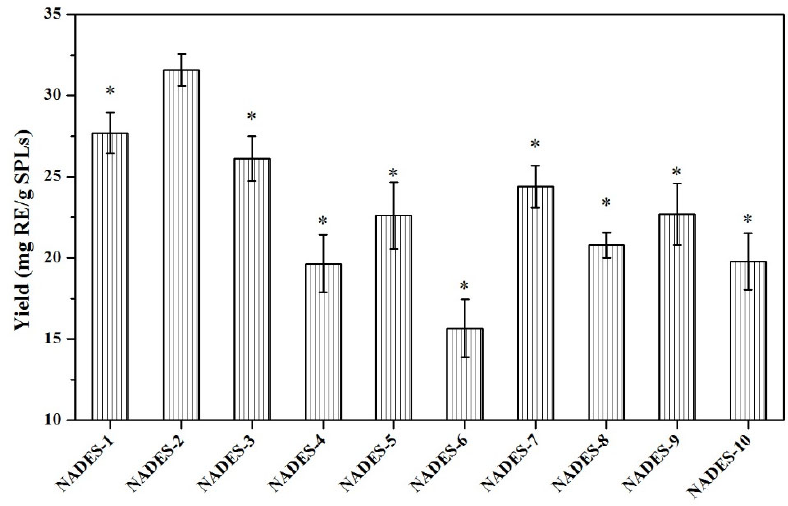
Figure 1. Extraction yields of total flavonoid compounds from SPLs. Extraction conditions: 0.1 g of SPLs in 1 mL of NADES systems (30% water, w / w ) by MAE (200 W) at 50 °C for 20 min. Yields of total flavonoid compounds that were significantly different from NADES-2 were indicated with * ( p < 0.05).